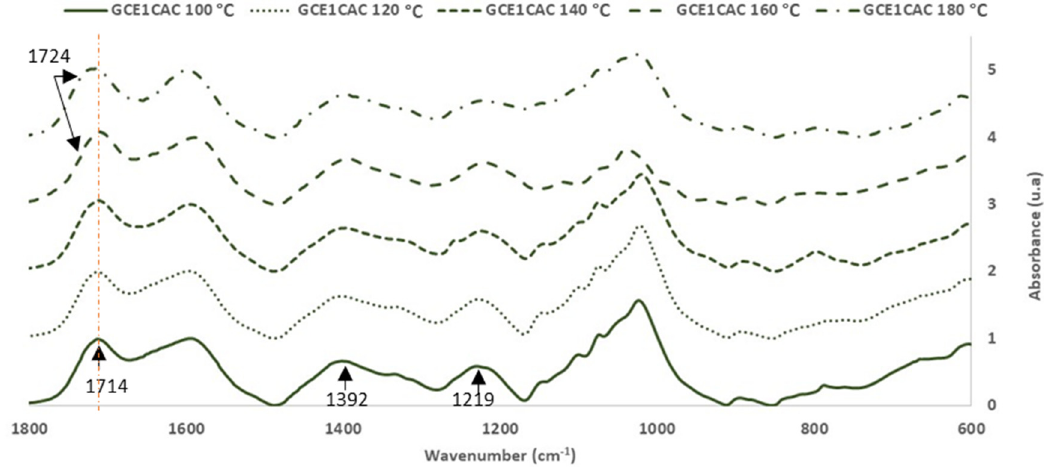
Figure 8. FTIR spectra: Grape cane extract GC E1 cured with citric acid (33% on adhesive weight, dry basis) at 100–180 °C (600–1800 cm − 1 ).